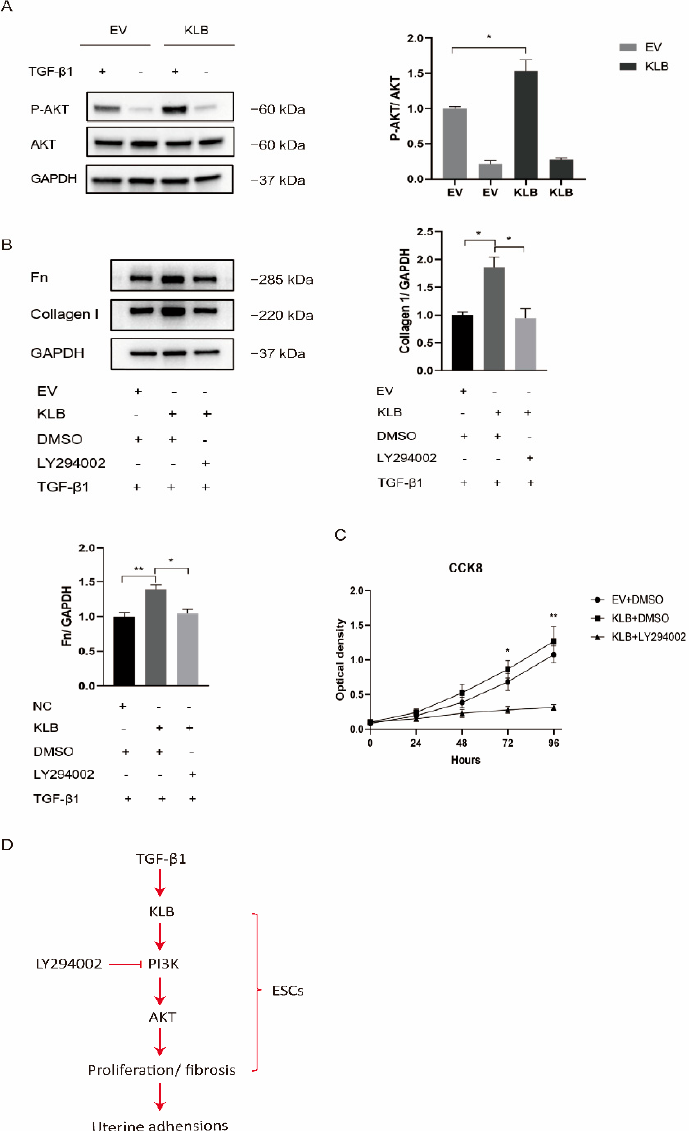
Figure 5. KLB promotes the fibrosis and proliferation of HESCs through the PI3K/AKT signaling pathway. ( A ) Through Western blot analysis, it was found that under the same stimulation with TGF- β 1, the expression of P-AKT in the KLB overexpression group was significantly higher than in the control group transfected with the empty plasmid. ( B ) Through Western blot analysis, it was found that LY294002, an inhibitor of PI3K, could rescue the protein levels of Collagen I and FN after KLB overexpression. ( C ) The cell proliferation ability was detected by the CCK8 assay, and it was found that LY294002 could also reduce the cell proliferation promoted by KLB overexpression. ( D ) The activation the PI3K/AKT signaling pathway by KLB plays a critical role in IUA by regulating ESC proliferation and fibrosis. * p < 0.05; ** p < 0.01.